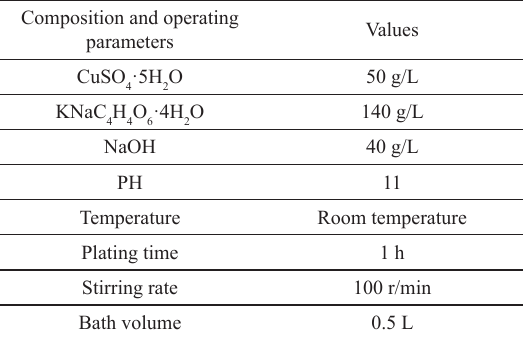
Table 2. The formulation and process for the preparation of copper layer.